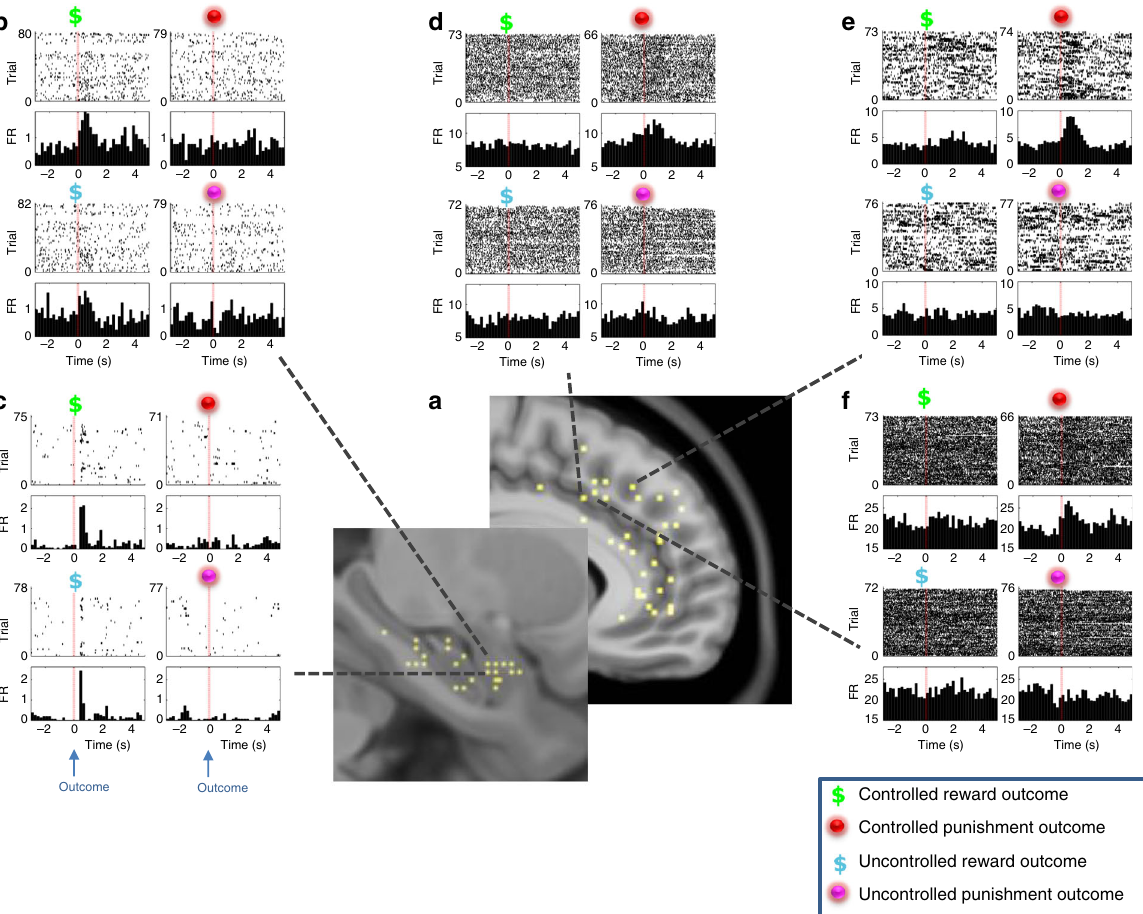
Fig. 2 Example neural responses to the different outcome conditions. a Sagittal slices show the location of active electrode contacts in mPFC and MTL areas (yellow markers, registered to an MNI atlas) that refer to the raster plots and peri-stimulus time histograms (PSTH), per condition (see legend for color codes). b , c PSTH from two different amygdala neurons showing signi fi cant increase in fi ring following reward outcome in both controlled and uncontrolled conditions. d – f PSTH from three different mPFC neurons showing signi fi cant increase in fi ring following punishment outcome in controlled but not in uncontrolled condition. Time 0 on the x -axis represents the timing of outcome (coin or ball hit the avatar). FR fi ring rate.